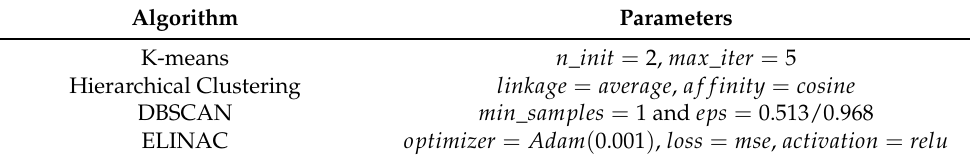
Table 4. Parameters set used in algorithms. Algorithm Parameters K-means n _ init = 2, max _ iter = 5 Hierarchical Clustering linkage = average , af finity = cosine